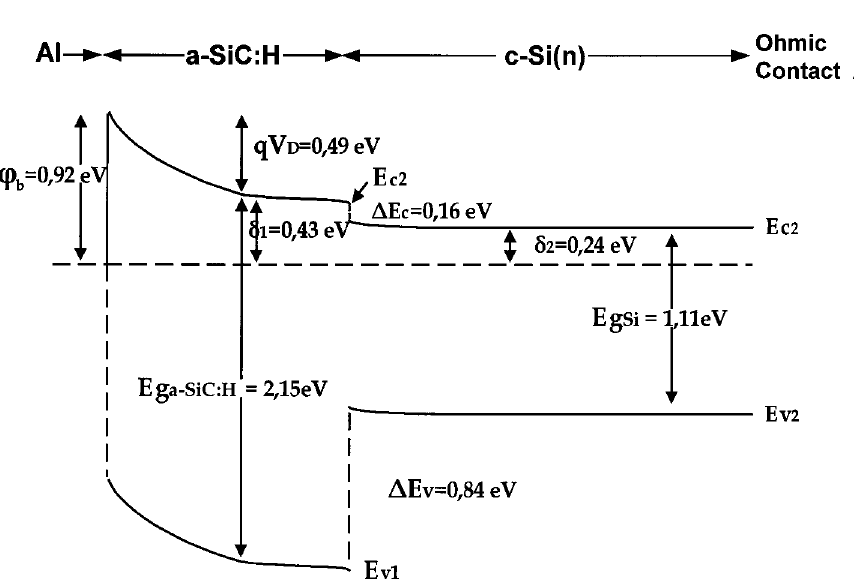
FIGURE 2 Energy band diagram of the Al = a-SiC:H = c-S(n) = Al structure under quasi